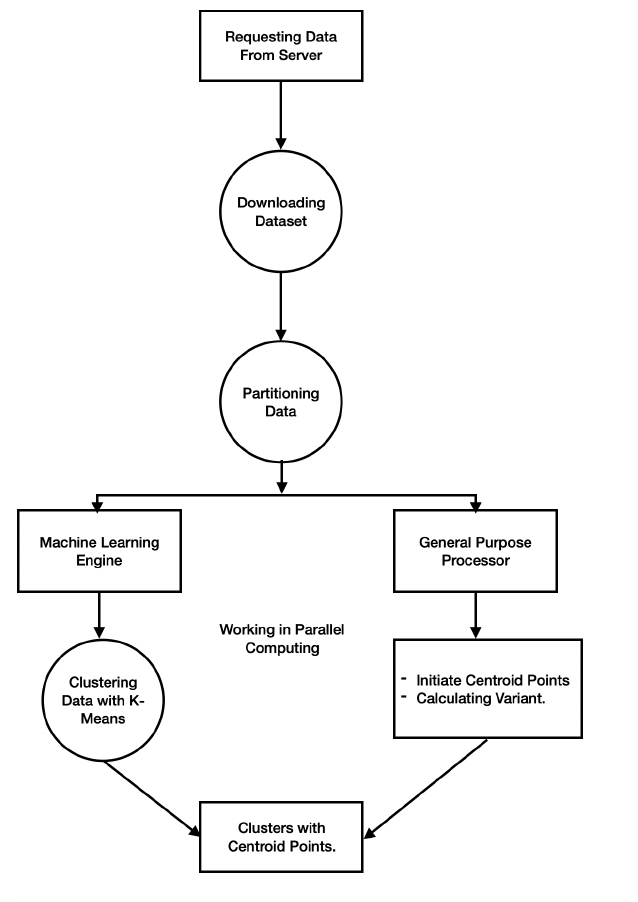
Figure 6. Proposed solution processing